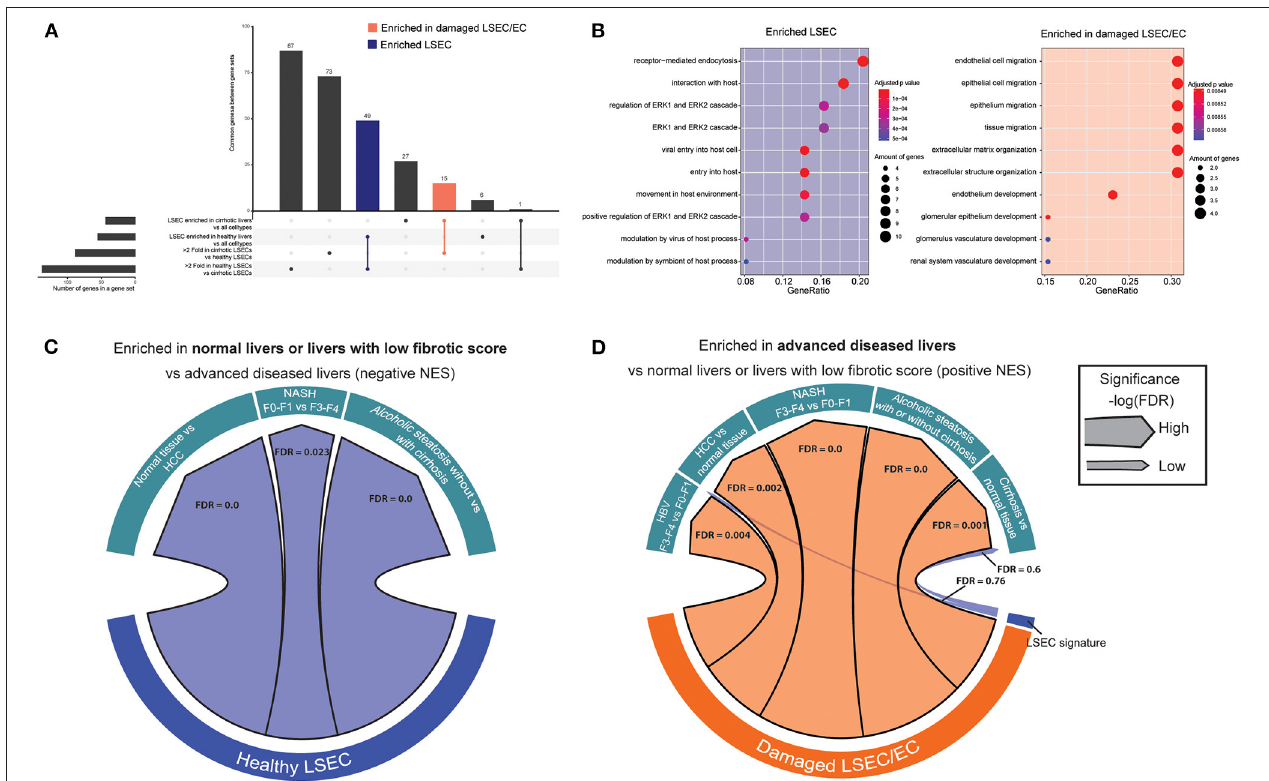
FIGURE 2 | Enriched gene sets in LSECs from healthy and cirrhotic livers identify healthy and damaged LSECs in chronic liver diseases. (A) Upset plot that combines genes that are differentially expressed between LSECs from healthy livers and damaged LSEC/ECs from cirrhotic livers and genes enriched in LSECs when compared to all other cell types in healthy and cirrhotic livers. Results were obtained with the use of the dataset of Ramachandran et al. (25). (B) Gene ontology analysis (biological processes) on enriched genes from LSECs and damaged LSECs/ECs. (C,D) Chord diagram of GSEA analysis [significance, –log(FDR)] of enriched genes from LSEC or LSEC/ECs in advanced liver diseases: cirrhotic livers (vs healthy livers) Wurmbach et al. ( 45), ASH (vs alcoholic steatosis) Trépo et al. (44), HCC (vs. normal tissue) Wurmbach et al. ( 45), NASH (F3–4 vs. F0–1) Murphy et al. (43) and HBV (F3–4 vs. F0–1) Wang et al. (42).